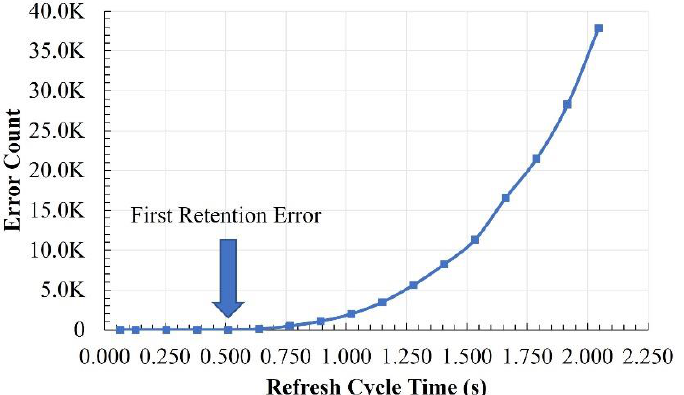
Figure 11. Retention error counts in Pseudo channel 0 of Channel 0 with varying RCT, and T L maintained at 70 °C.